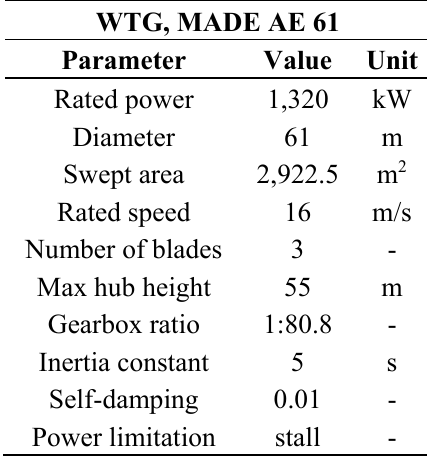
Table A3. Technical characteristics of the wind turbine.